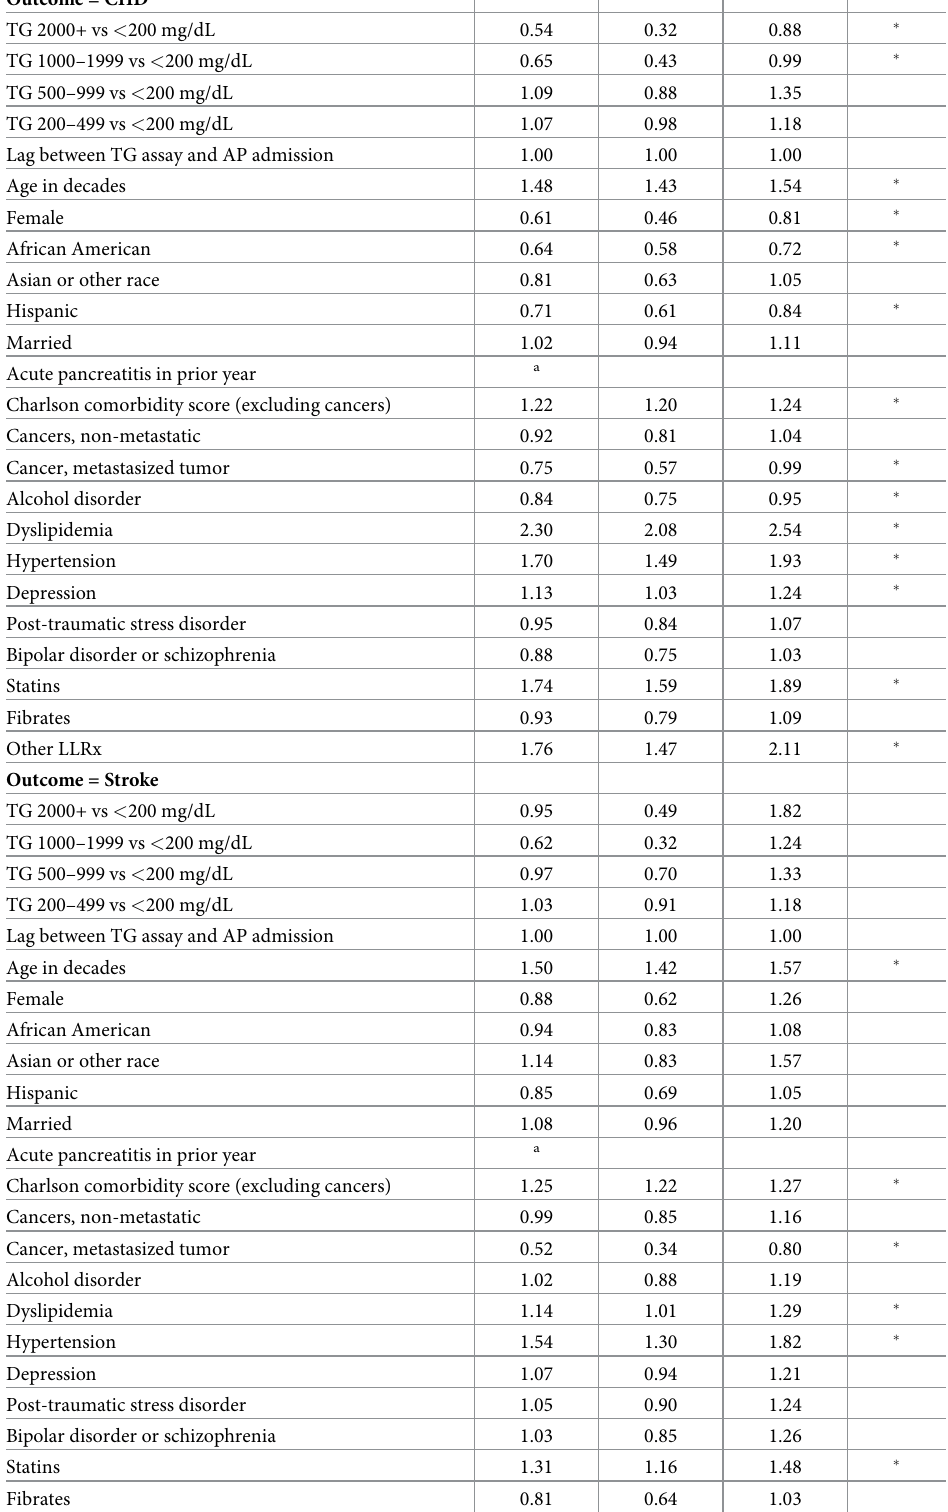
Table 2. Factors associated with post-acute pancreatitis outcomes among 20,608 VA patients (FY2006-FY2009). Outcome =